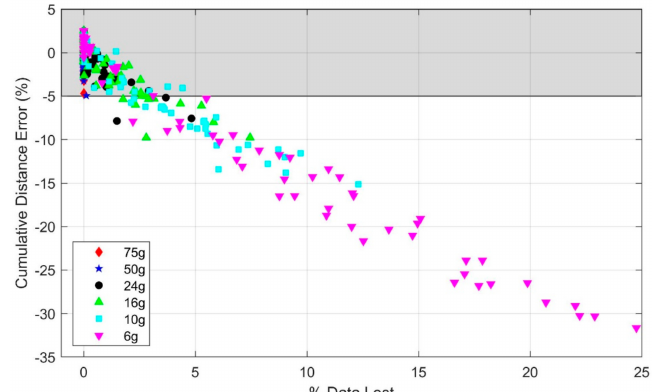
Figure 5. Cumulative distance error versus percentage of acceleration data lost due to saturation for all trials and for each accelerometer range. The shaded region indicates estimates within ± 5% error.